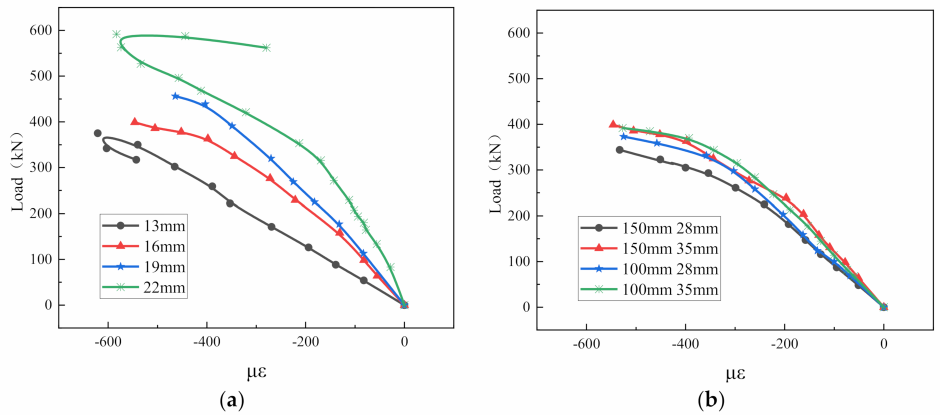
Figure 9. Reinforcing bar load–strain curve: ( a ) 150 mm spacing, 35 mm length stud specimen; ( b ) 16 mm